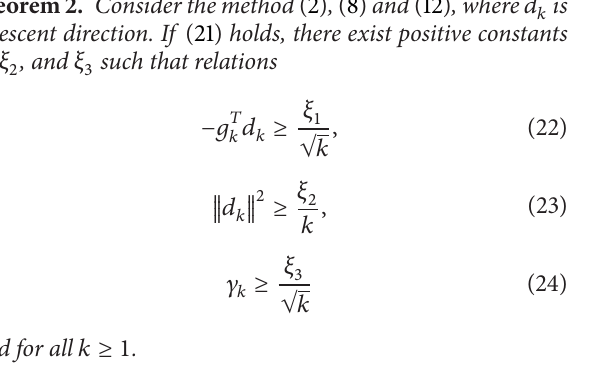
Figure 1: Performance profiles for CPU